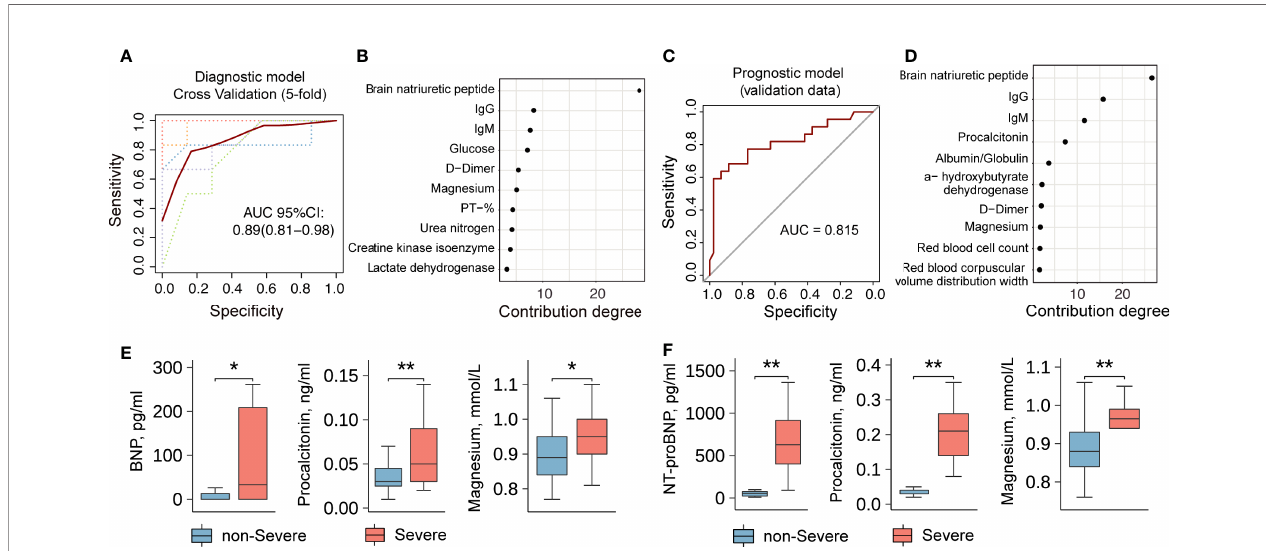
FIGURE 4 | A diagnosis and severity prediction model for COVID-19 patients. (A) The diagnostic model for asymptomatic and presymptomatic patients. Lines represent the Receiver Operating Characteristic (ROC) curve of diagnostics of training (red line) and fi ve-fold cross-validation (dotted lines). The dotted lines in different colors represent the results of 5-fold cross-validation. (B) The contribution degrees of markers (Top 10) in the diagnostic model. The horizontal axis represents the contribution degree of laboratory indicators. (C) The prognostic model for the severity of presymptomatic patients. (D) The contribution degrees of markers (Top 10) in the prognostic model. The horizontal axis represents the contribution degree of laboratory indicators. (E) and (F) A comparison of laboratory indicators between non-severe and severe patients without symptom on admission. The data set in (E) comes from Wuhan Huoshenshan Hospital in China. The validation data set in (F) comes from the First People ’ s Hospital of Jiangxia District of Wuhan, Hubei, China. ** represents P -value < 0.01. * represents P -value <